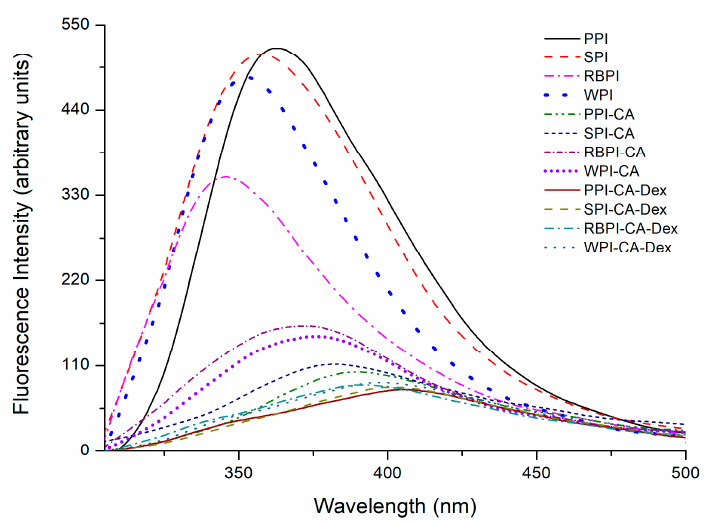
Figure 2. Fluorescence spectra of NP, PC, and PCD samples.